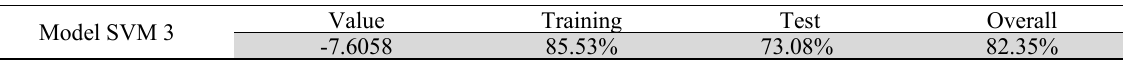
The results of SVM-3 model